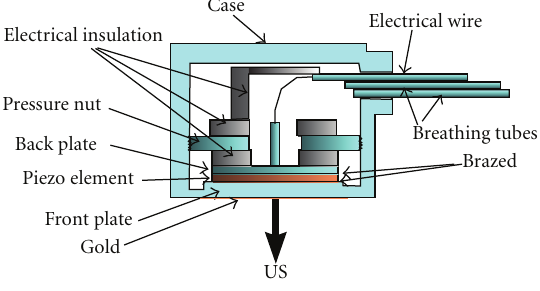
Figure 14: TUSHT general